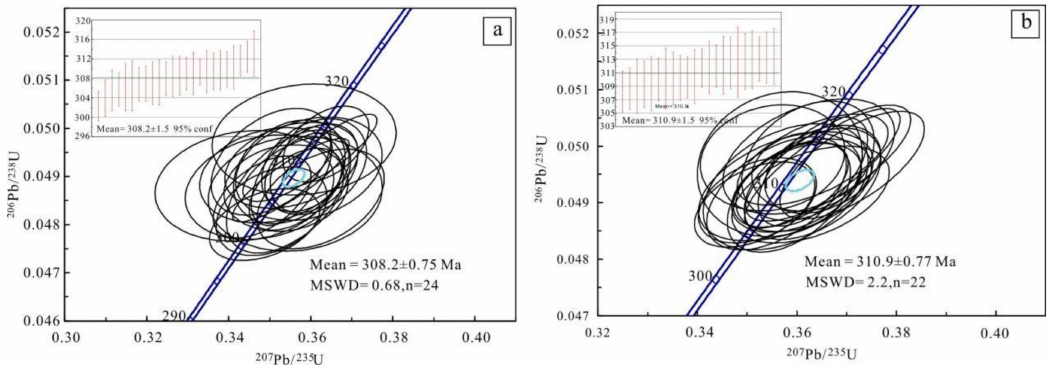
Figure 7. Zircon U–Pb concordia diagrams for ( a ) SR2, ( b )